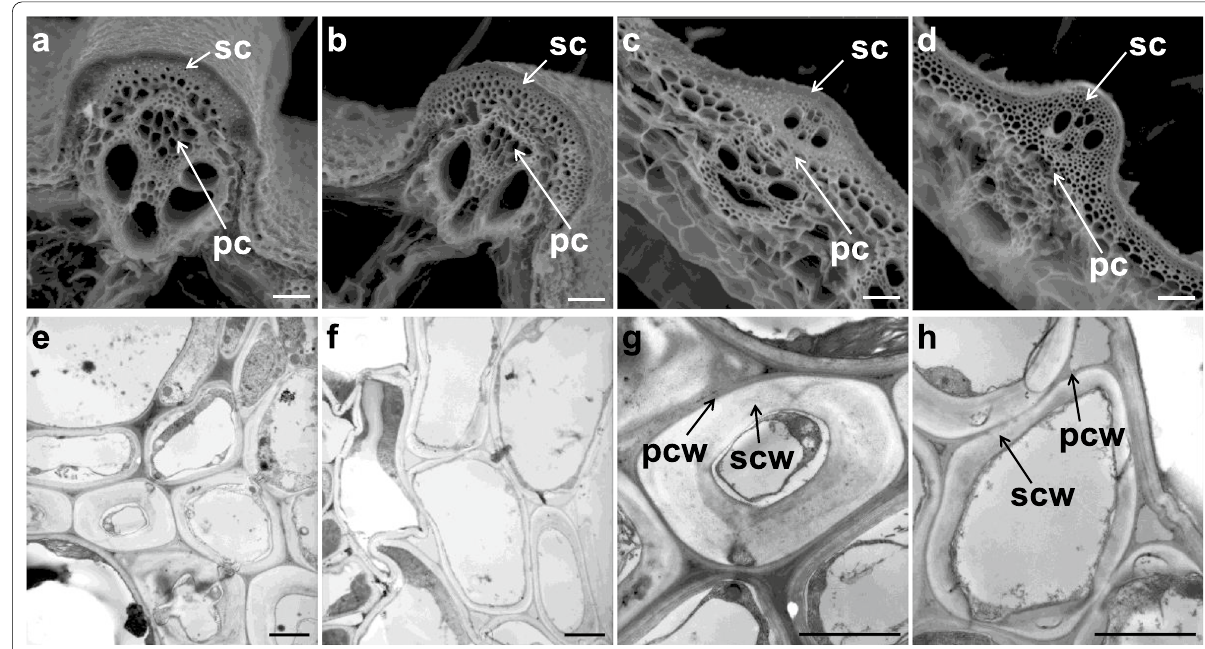
Fig. 2 Environmental scanning electron microscope images ( a - d ) and transmission electron microscope images ( e – f ) of Bc19 mutant and wild-type plant. a and b Transverse section of the wild-type and Bc19 mutant leaf vein, respectively. c and d Transverse section of the wild-type and Bc19 mutant culm, respectively. e and f Sclerenchyma cells of the wild type and Bc19 mutant, respectively. g and h Single cell in sclerenchyma tissues of the wild type and Bc19 mutant, respectively. sc, sclerenchyma tissues; pc, parenchymatous tissues; pcw, primary cell wall; scw, secondary cell wall. Scale bar equals 40 μm in a – d and 10 μm in e –